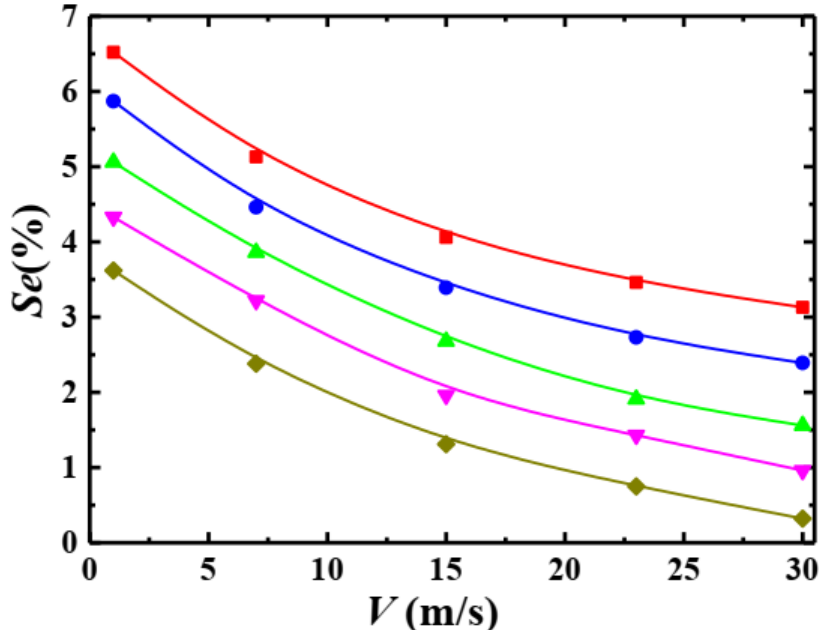
Figure 7. Relationship between Se and V for different concentrations ( d p = 100 µ m, m s = 15 t/h). α s : (cid:4)